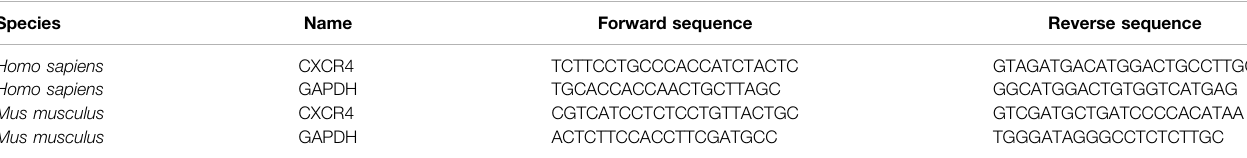
TABLE 1 | qPCR primers for mRNA used in the study. Species